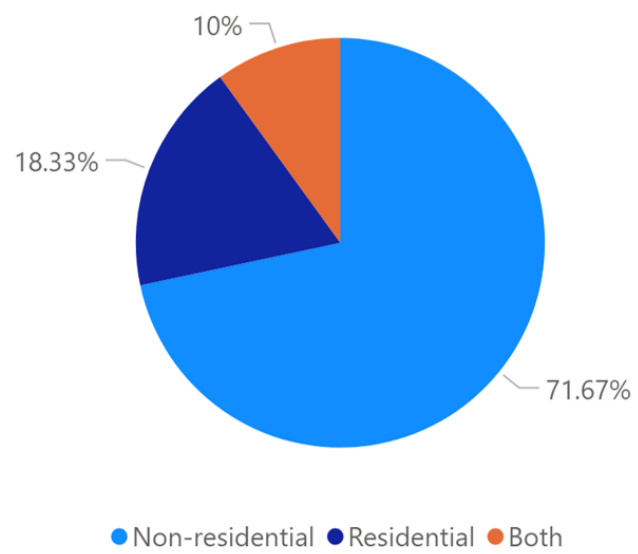
Figure 5. Comparison between building type and forecasting methods.